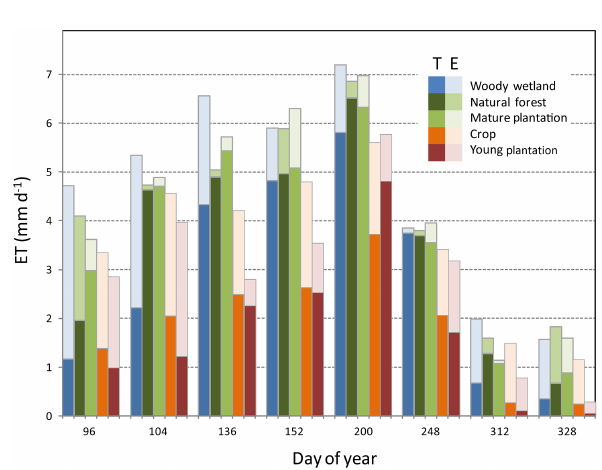
Figure 14. Average cumulative ET at DOY 330 in 2013 over dif- ferent land cover types, and standard deviations within the sample populations (the black bar).